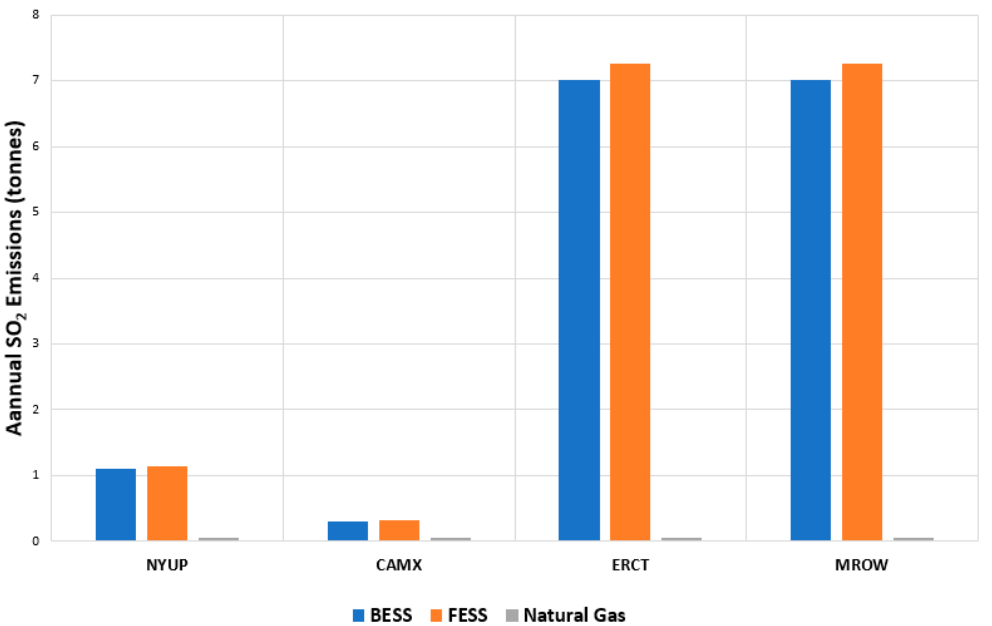
Figure 6. Annual SO 2 emissions when providing Reg A frequency regulation service with compensated generation for upstate New York (NYUP), California (CAMX), Texas (ERCT), and the upper Midwest (MROW). The BESS and FESS emissions are similar for all regions with the BESS having slightly lower emissions. The compensated generation natural gas plant has significantly lower SO 2 emissions than the ESS